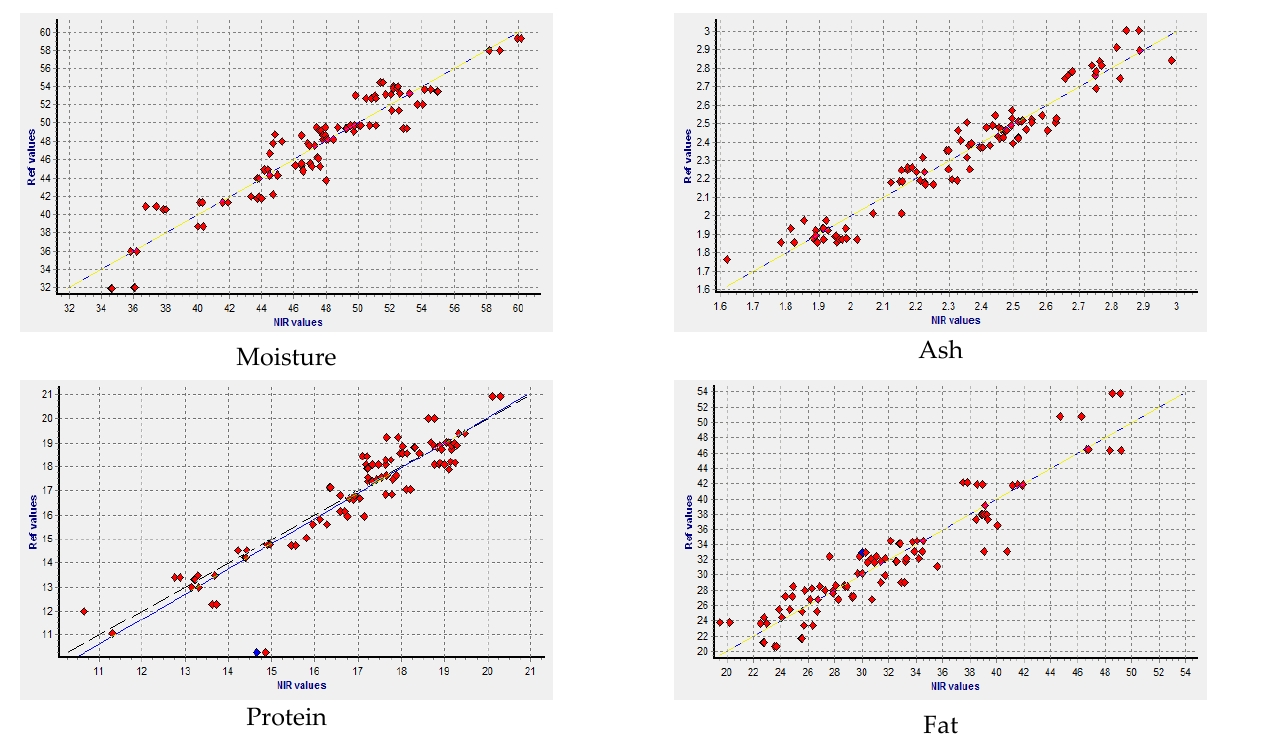
Figure 2. Plots for measured (Ref) versus estimated (NIR) values for moisture, ash, protein, and fat content of traditional sausages. Dashed lines represent the reference lines for the expected behavior. Solid lines are the actual regression lines.